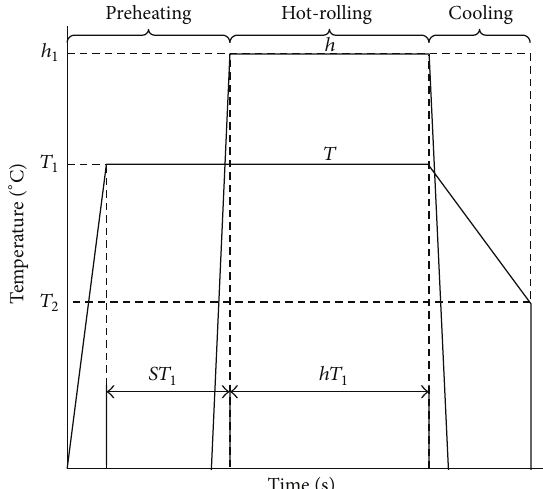
Figure 3: Curve of temperature versus that in hot-rolling process.